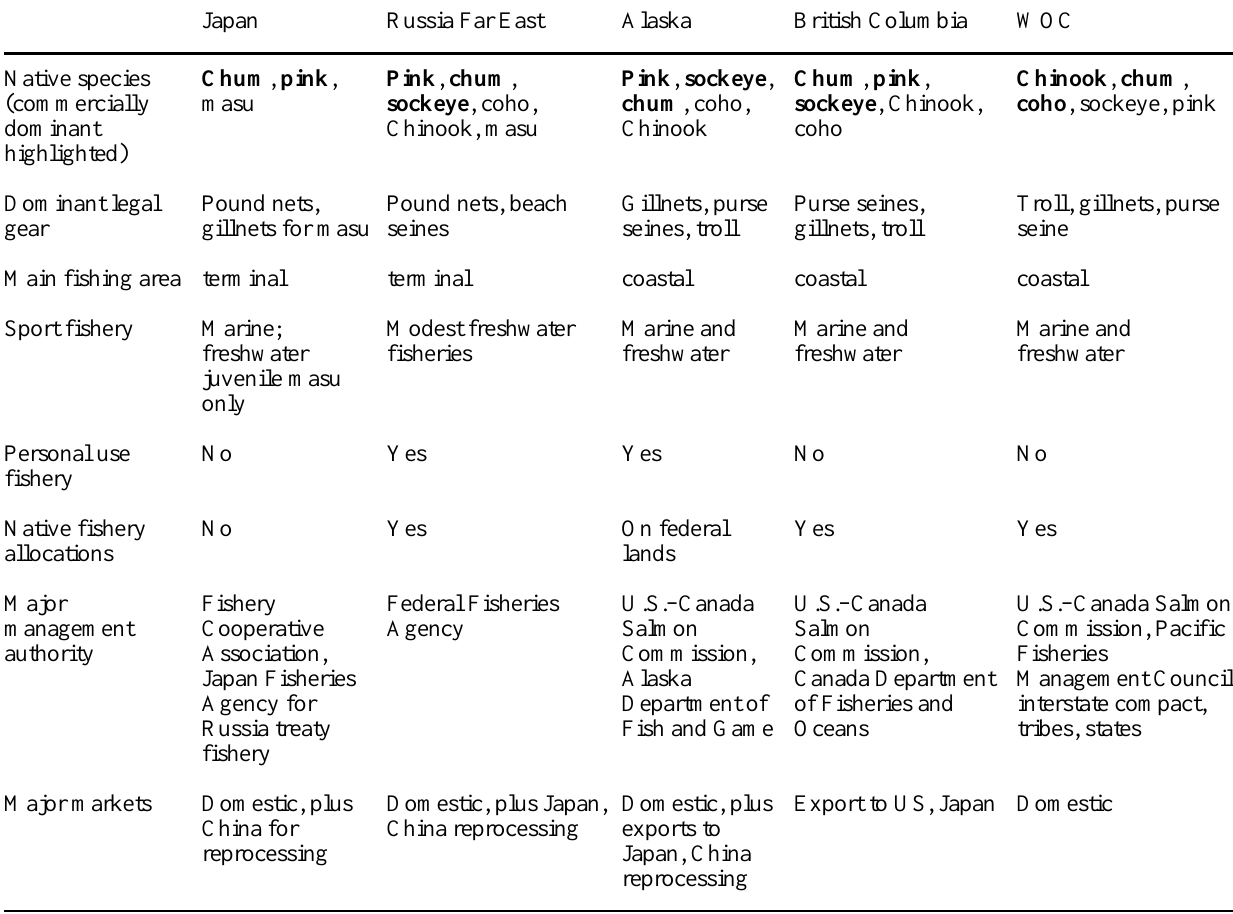
Table 1. Attributes of five salmon fishing